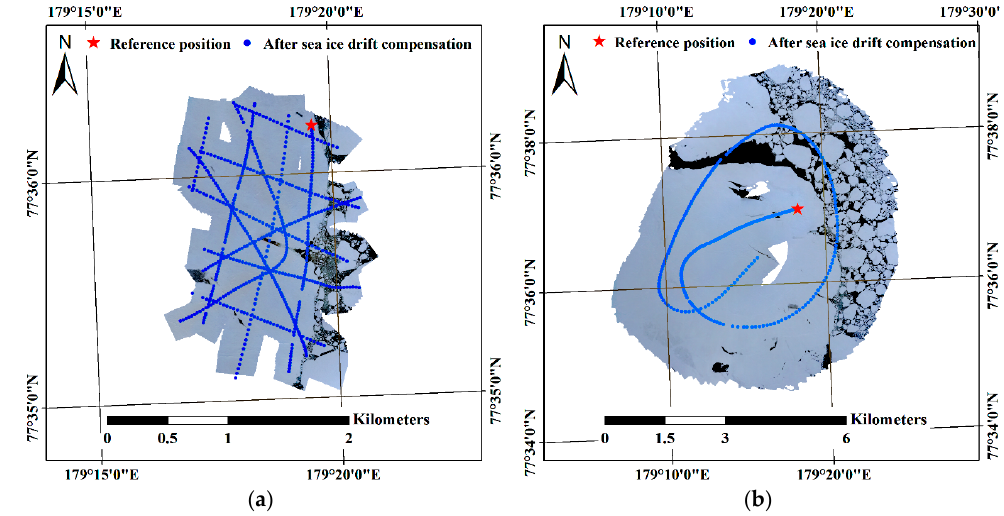
Figure 8. Mosaicked VHR image after compensation for the effect of sea ice drift: ( a ) the mosaicked result using the Subset I images, i.e., those acquired at the altitudes range between 200 and 400 m; and ( b ) the mosaicked result using the Subset II images, i.e., those acquired at altitudes higher than 1000 m. Table 5. Quality assessment using the imaging locations before and after the sea ice drift compensation.